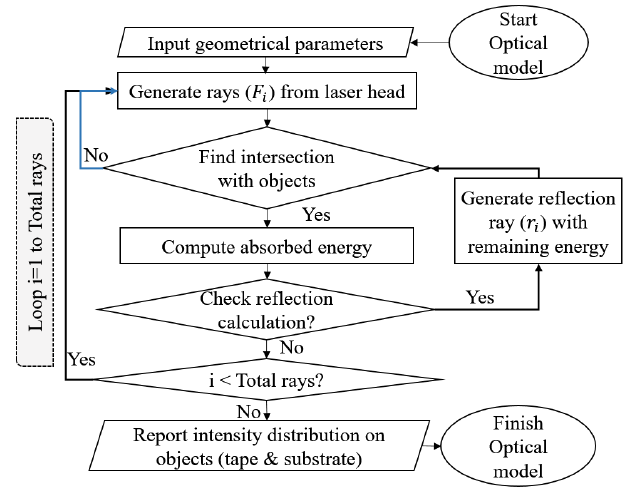
Figure 5. Flowchart of the optical